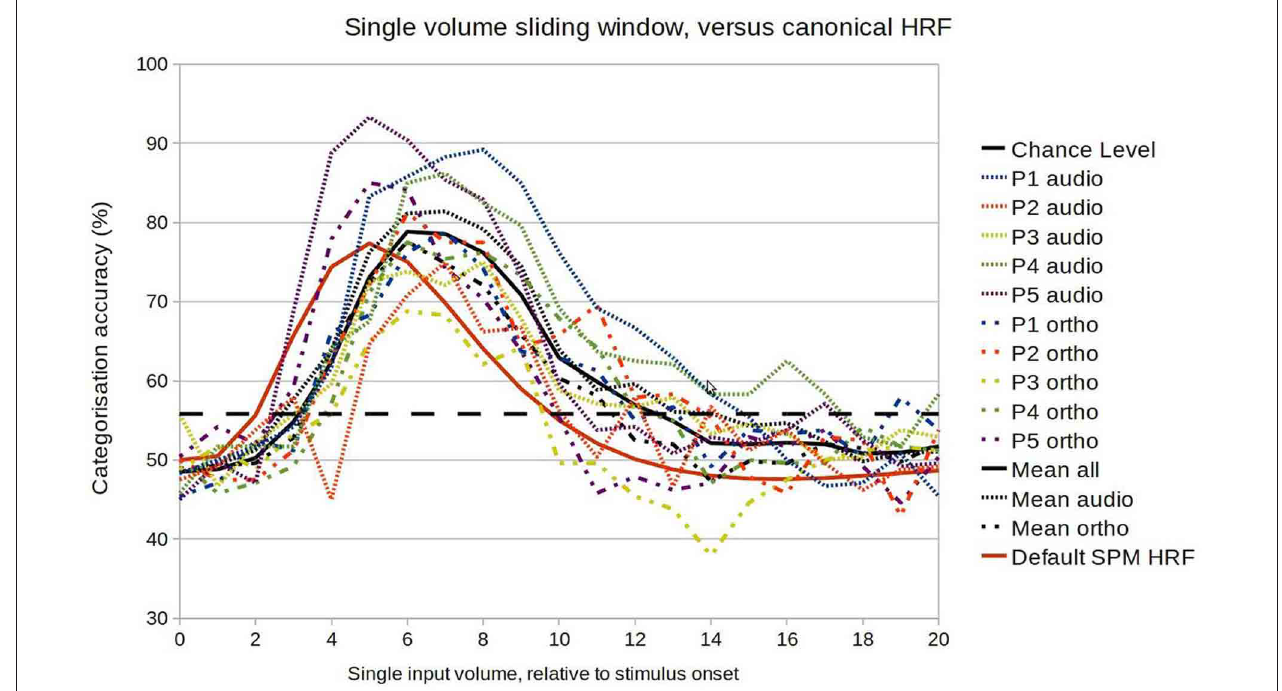
FIGURE 4 | Comparison between the model accuracy function and the canonical HRF in the range of 0–20s after stimulus onset.